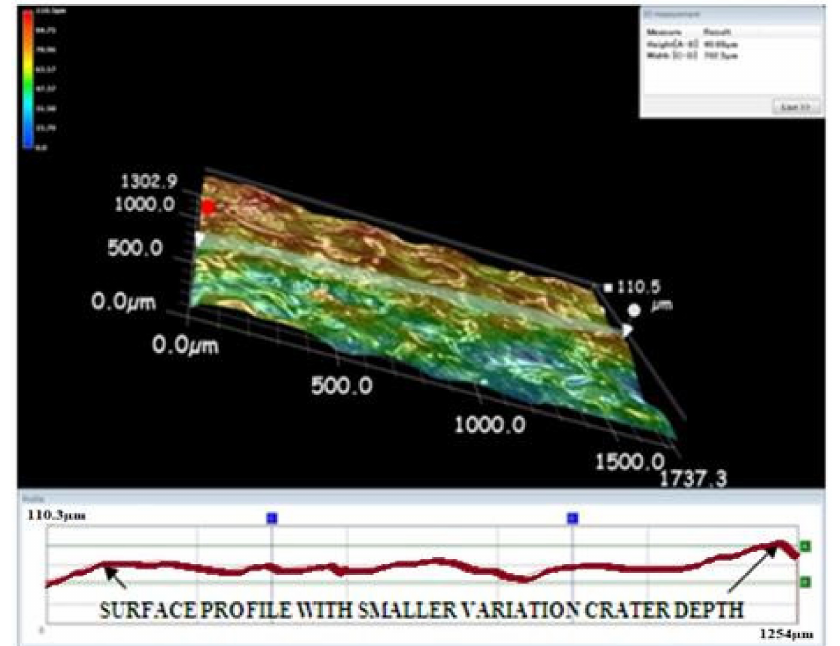
Figure 10. Three-dimensional view of the machined surface using the brass tool